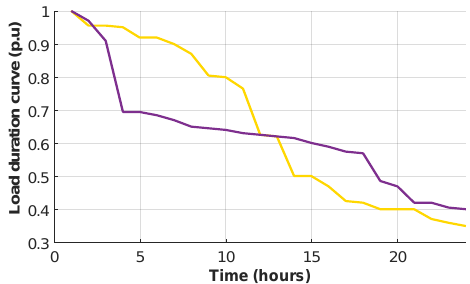
Figure 2. Load duration curves for residential (purple) and industrial (yellow) sectors.